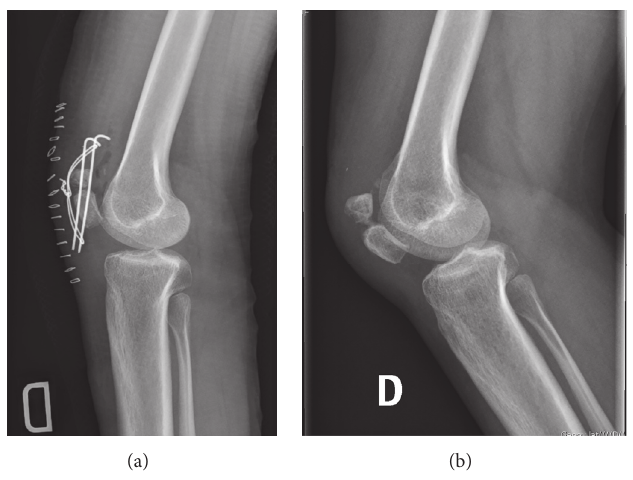
Figure 3: Immediate postoperative (a) and 8-month (b) lateral knee